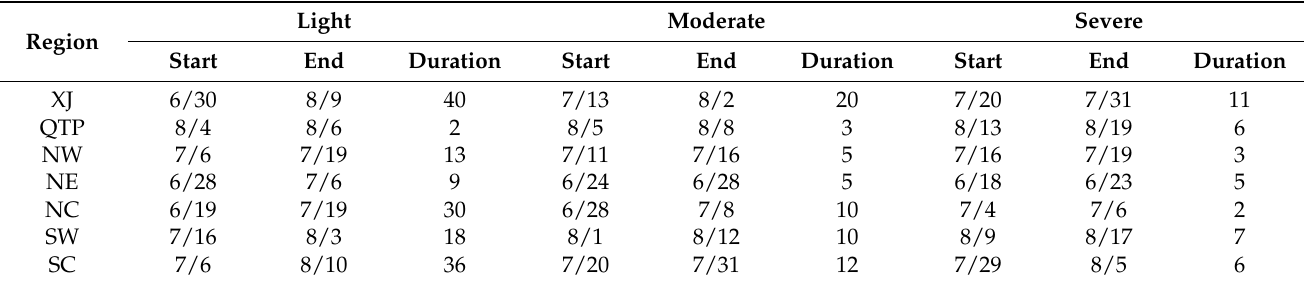
Table 4. Onset, termination, and duration of heatwaves at different levels over seven subregions.